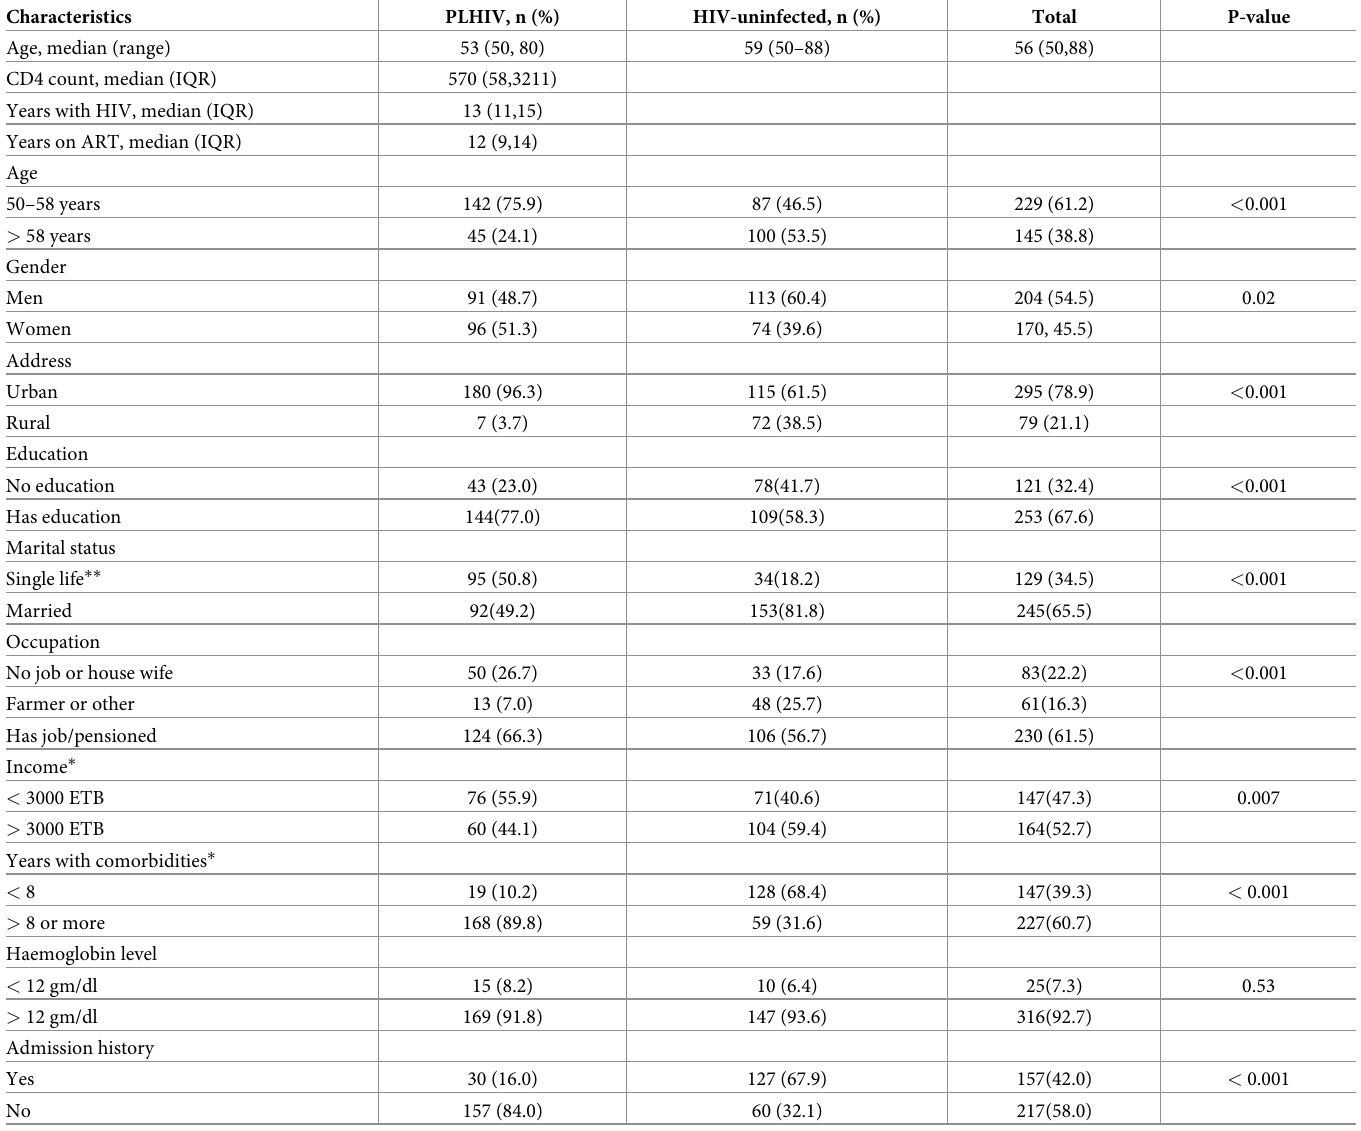
Table 1. Socio-demographic and clinical characteristics of the study